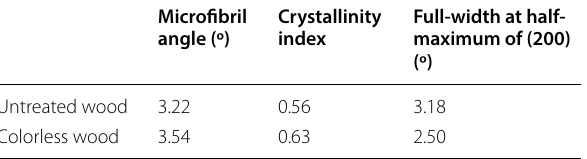
Table 4 Microfibril angle, crystalline index and full-width at half-maximum of untreated and colorless wood